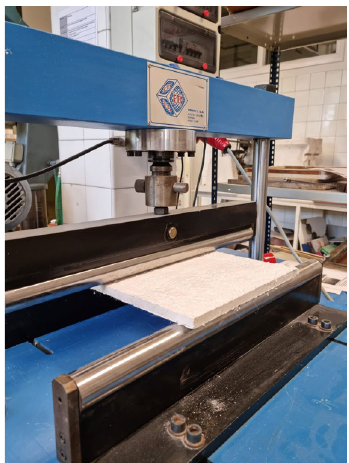
Figure 2. Bending test machine by Proeti, S.A. in Madrid.